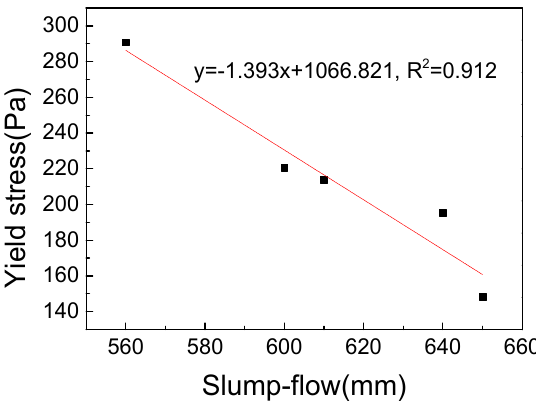
Figure 2. E ff ect of charging sequence on the rheological parameters of SCC. Figure 2. Effect of charging sequence on the rheological parameters of SCC.